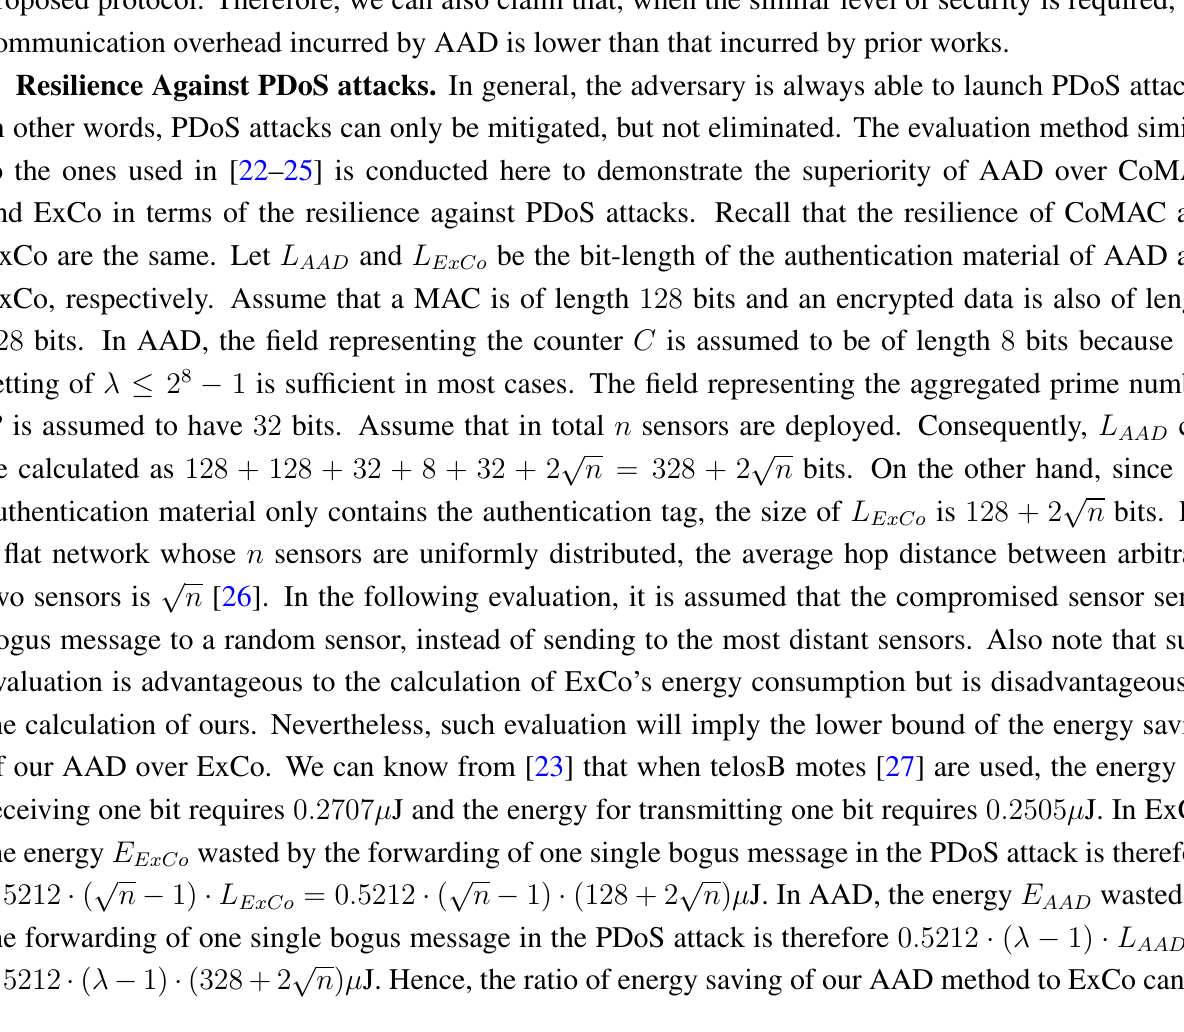
Figure 9. P in the setting of n = 100 , k = 10 , and | N AAD